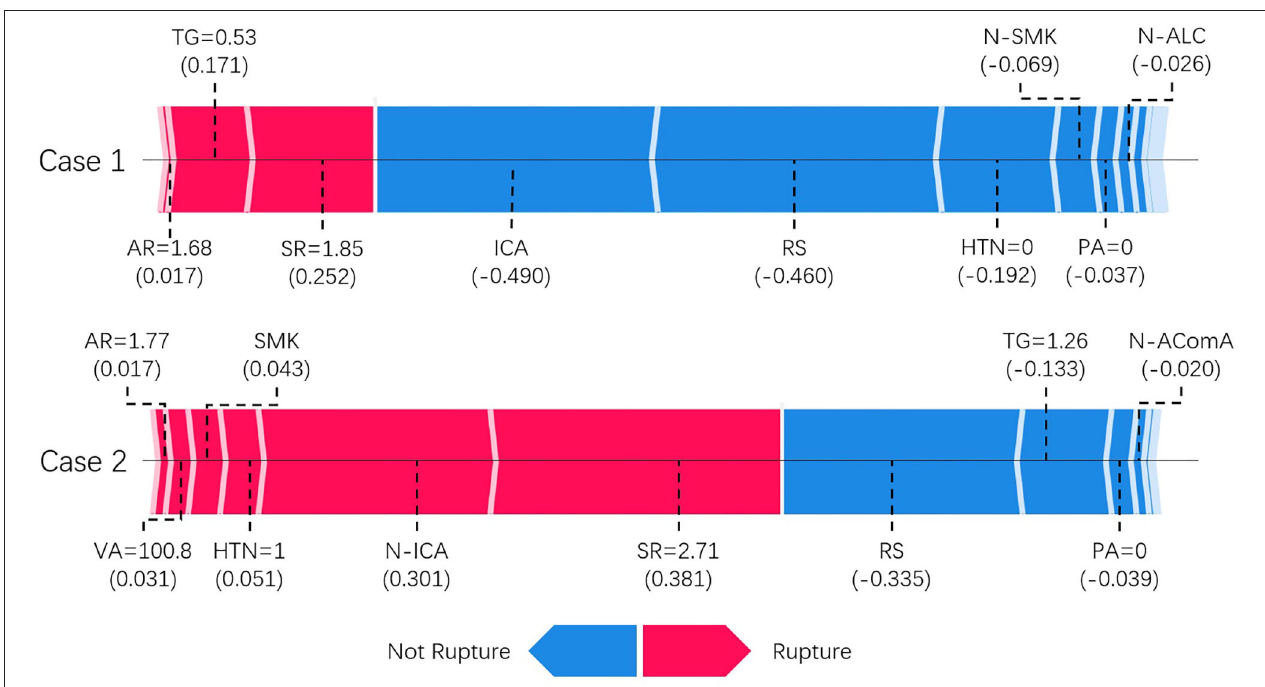
FIGURE 4 | SHAP model explanation of two typical predictions. This shows the main contributing features behind the model prediction. Features linked to red color bar contribute to rupture prediction, whereas features linked to blue color bar contribute to unruptured prediction. The length of the color bar represents the amount of contribution, measured by SHAP value shown in parenthesis, from the corresponding feature. TG, triglyceride; SR, size ratio; RS, regular shape; AR, aspect ratio; NW, neck width; HTN, hypertension; PA, physical activity; VA, vessel angle; N-ICA, aneurysms not on internal carotid artery; N-AComA, aneurysms not on anterior communicating